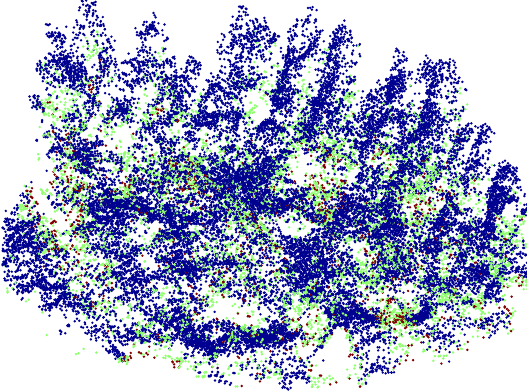
Figure 3. An example point cloud of a single plot generated at an average altitude of 48.32 m . First (blue), second (green) and third (red) returns are all shown in the